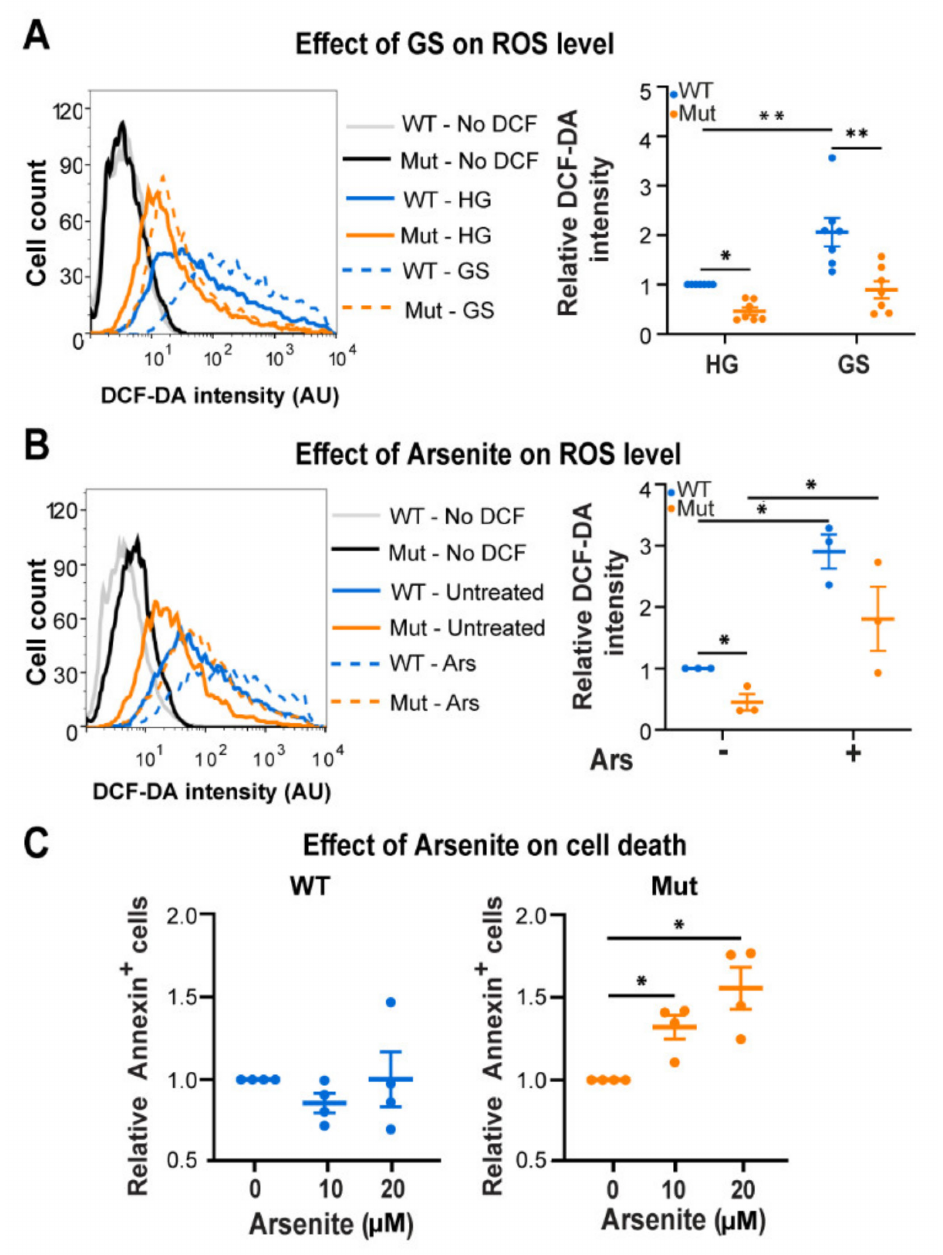
Figure 4. GS connection to ROS and the effect of ROS on WT (blue) and Mut (orange) primary astrocytes. Cells were incubated for 48 h with either DMEM-HG or DMEM-GS medium ( A ), or with DMEM-HG followed by 4h treatment with 20 µ M Ars ( B ), or for 24 h with 10 or 20 µ M Ars ( C ). Cells were then stained with DCF-DA ( A , B ) or with FITC-conjugated Annexin-V antibodies ( C ) followed by flow cytometry analysis. Left panels show representative histograms. Right panels show the mean fluorescence intensity of DCF-DA relative to WT-HG ( A , B ) or fold change of Annexin-V positive cells relative to WT-HG ( C ). All Data represent the average values ± SEM. Statistical analysis is detailed in Materials and Methods. * p ≤ 0.05, ** p ≤